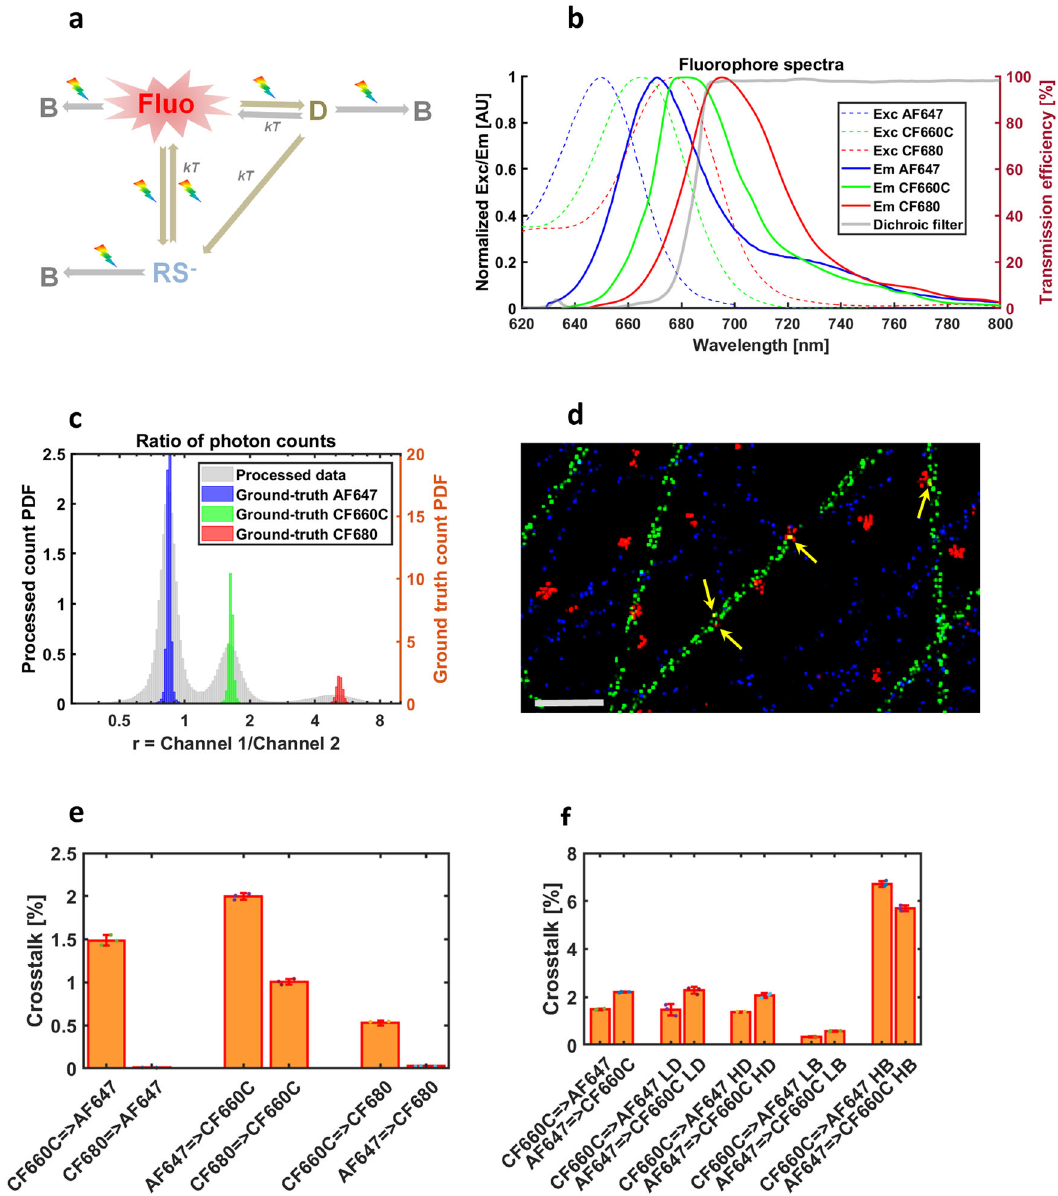
Fig. 4 Spectral demixing SMIS simulations of Alexa647, CF660C, and CF680 labeling microtubules, actin and clathrin. a Employed photophysical model for the three fl uorophores. D: ms-lived dark state; B: bleached state; RS - : sulfur anion adduct; kT: thermal relaxation; rainbow arrow: light sensitivity ( b ) excitation (dashed lines) and emission (plain lines) spectra of AF647 (blue), CF660C (green) and CF680 (red) as used in SMIS. The transmission spectrum of the dichroic fi lter is shown in gray (right axis). c Univariate histogram of fl uorophore count ratios in SMIS-generated 3-color spectral demixing dataset. The histogram from processed data (left axis) is overlaid on the ground truth histograms for the 3 fl uorophores (blue: AF647; green: CF660C; red: CF680) (right axis). r: ratio of photon counts between channel 1 (shorter wavelengths) and channel 2 (longer wavelengths). d Extract of the rendered unmixed 3-color image (blue: AF647; green: CF660C; red: CF680). Examples of crosstalk events are highlighted by yellow arrows. Scale bar: 1 μ m. e Crosstalks between pairs of fl uorophores in the unmixed 3-color image. f Crosstalk between AF647 and CF660C in unmixed 2-color images acquired under various conditions (LD/HD: Low/High localization density; LB/HB: Low/High background fl uorescence). Error bars in ( e ) and ( f ) were computed by randomly splitting datasets in n = 3 subsets. Colored dots show individual data